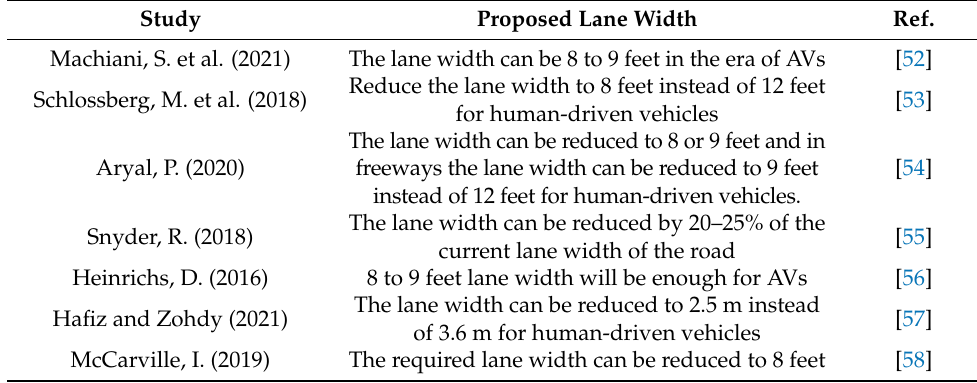
Table 7. Summary of the proposed lane width for AVs from across different studies. Study Proposed Lane Width Ref.